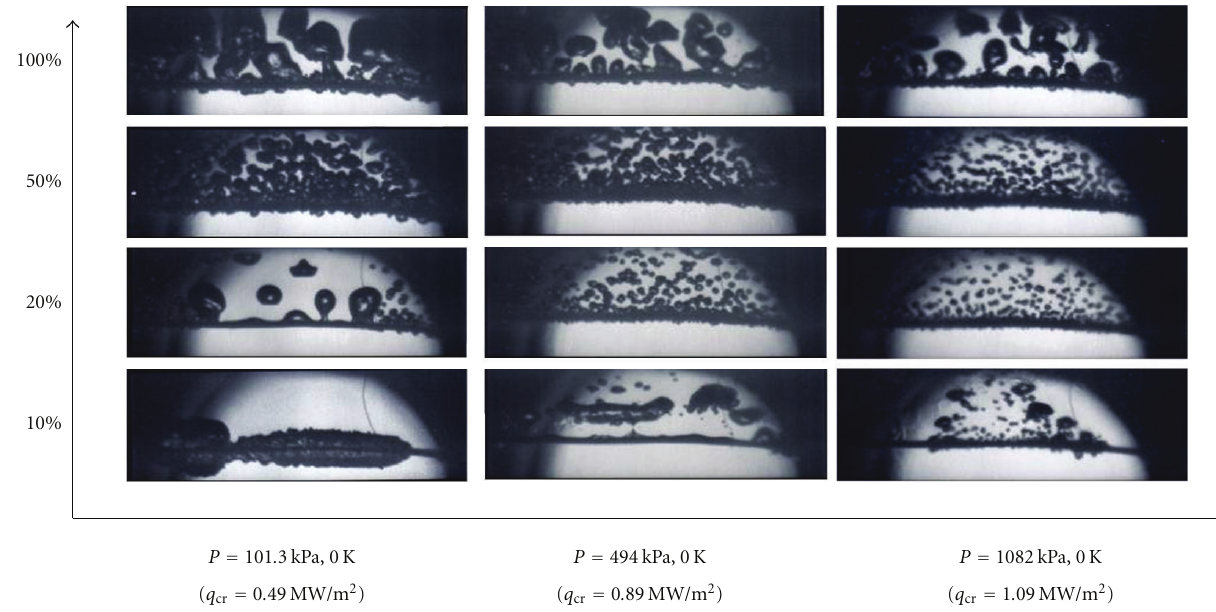
Figure 6: Vapor film behavior during transition to CHF at pressures of 101.3, 494, and 1082 kPa in saturated ethanol due to quasi-steadily increasing heat input given by exponential time function.